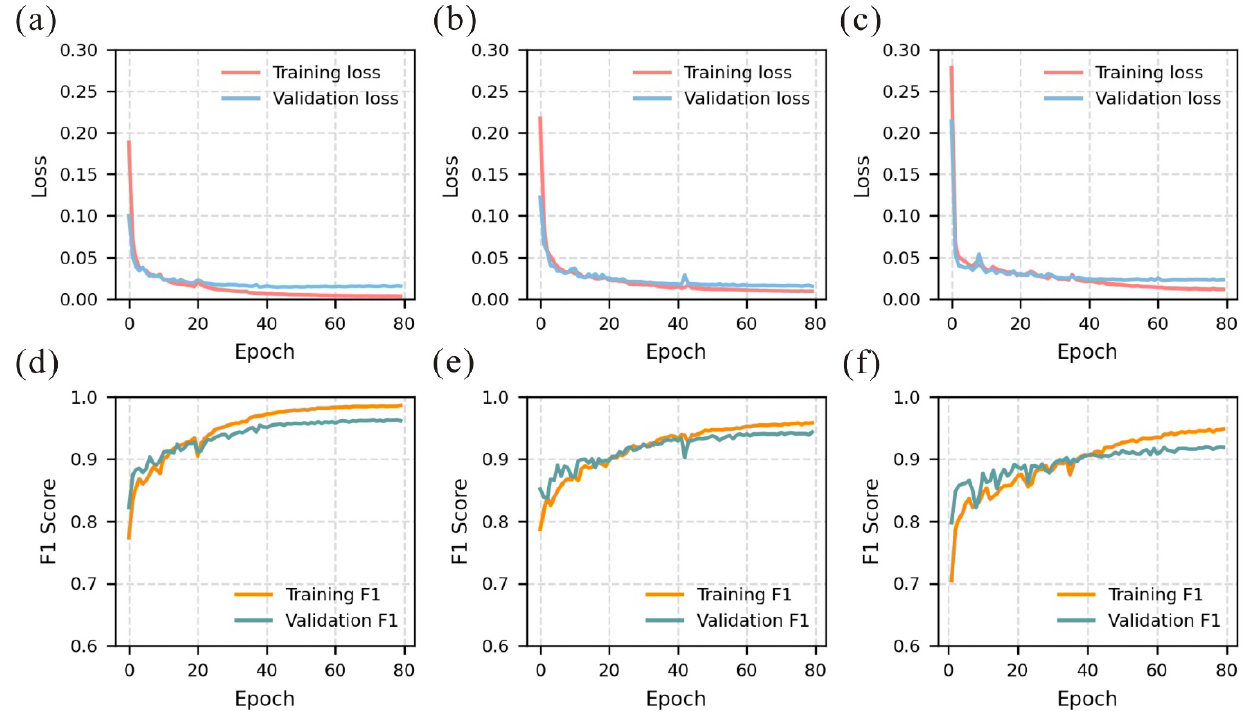
Figure 9. The loss and f1 score of DRs-UNet, U-Net, and SegNet from left to right, respectively; ( a – c ) loss curve during training and validation, ( d – f ) F1 curve during training and validation.